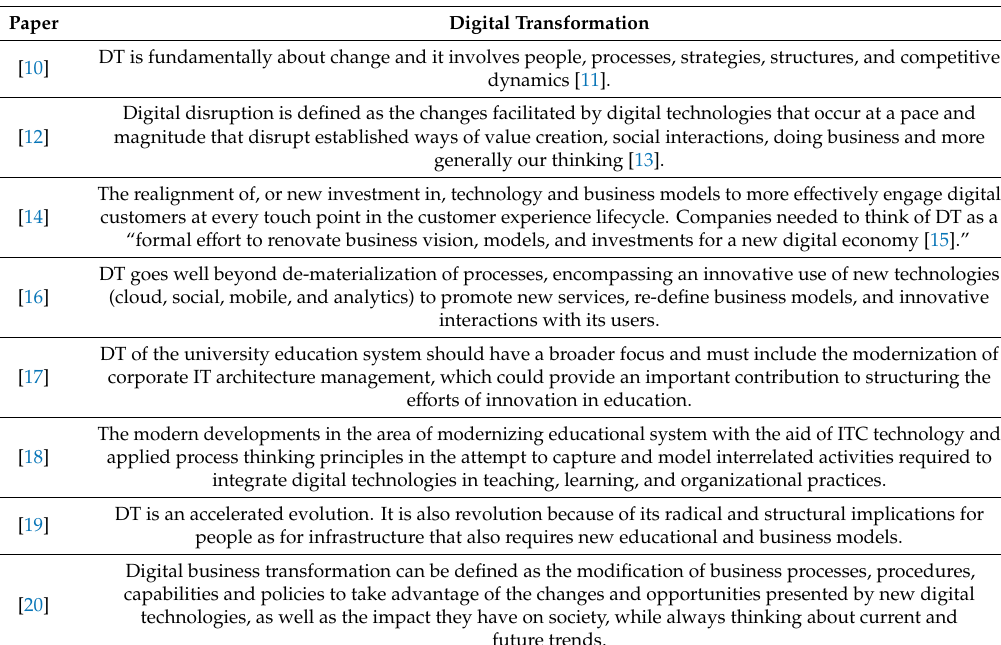
Table 6. Definitions related to DT in HEIs.